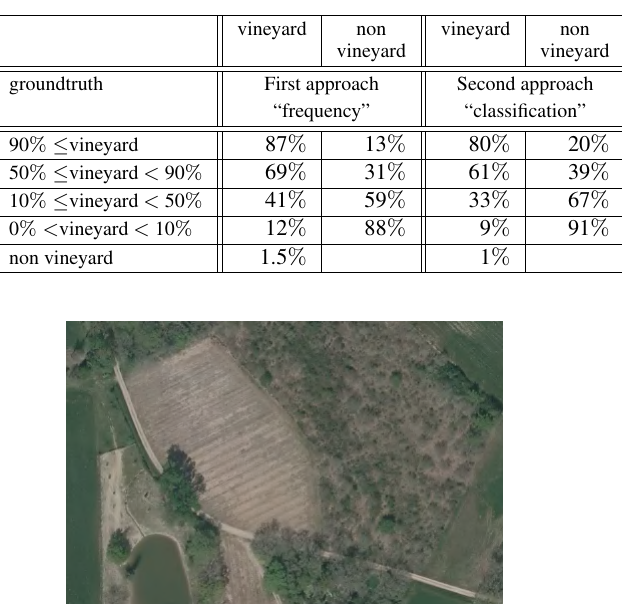
Table 1: First data set : results of the approaches “frequency anal- ysis” and “classification” (using per region maximum likelihood classification algorithm applied to SIFT based texture indexes)